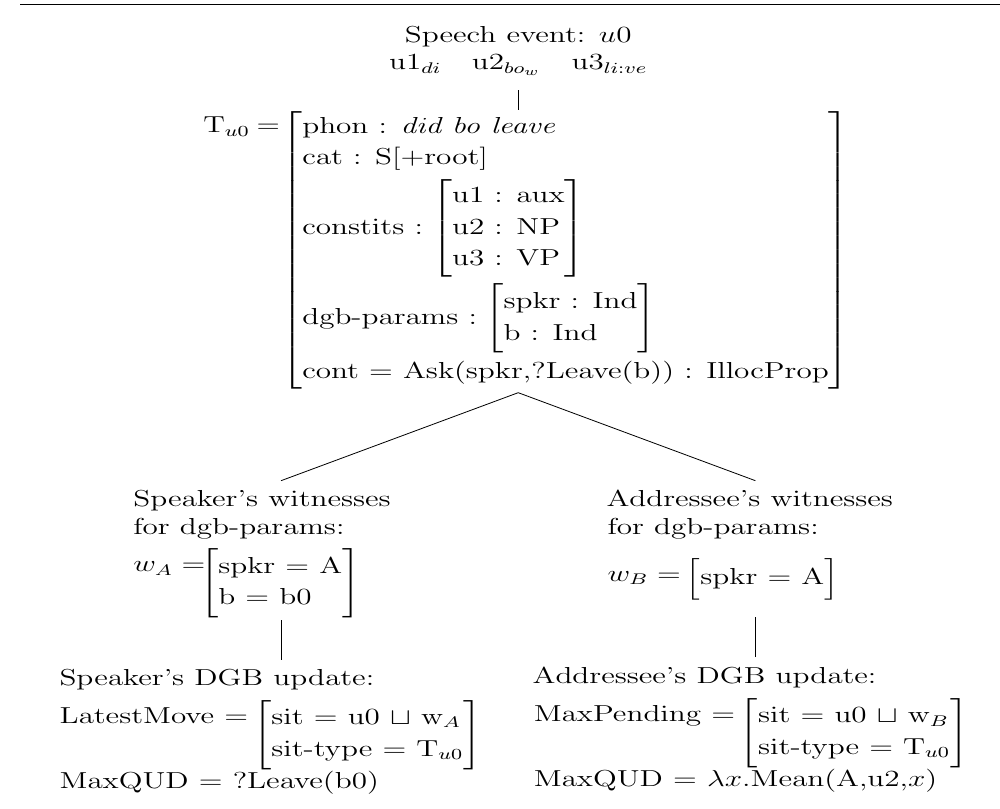
A single utterance giving rise to distinct updates of the DGB for distinct